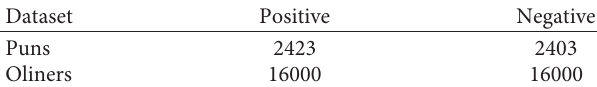
Table 1: Statistics: Puns and